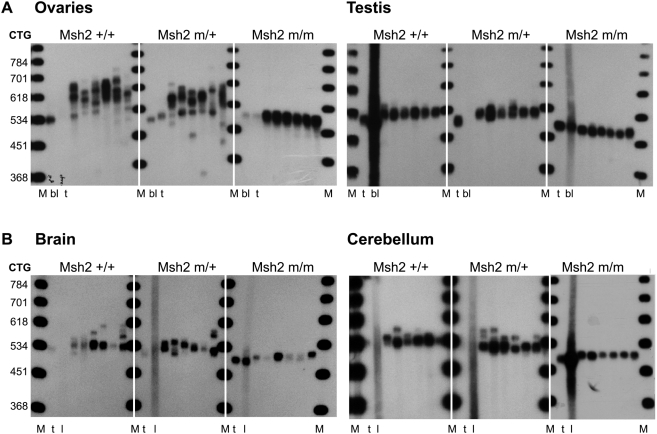
Representative SP-PCR analyses of CTG repeats in DNA molecules extracted from 8-month-old transgenic mouse tissues.The autoradiographs show representative SP-PCR analyses of DNA, extracted from ovaries and testis (A), brain and cerebellum (B). Genotypes are indicated. CTG repeat numbers determined in tail DNA at weaning are: 535 (Msh2+/+); 512 (Msh2m/+); 499 (Msh2m/m) in mice used to analyse DNA from ovaries and 525 (Msh2+/+); 516 (Msh2m/+); 500 (Msh2m/m) in the mice used for other tissues. t, tail; bl, blood; l, liver; M. 250 bp DNA ladder converted to number of repeat units in the given PCR product. About 2–10 amplifiable DNA molecules (ovaries, brain and cerebellum) and 10–50 transgene molecules (testis) were amplified. Msh2+/+, m/+ and m/m represent genotypes at the murine locus for Msh2. +: wild-type allele; m: Msh2G674A mutation.